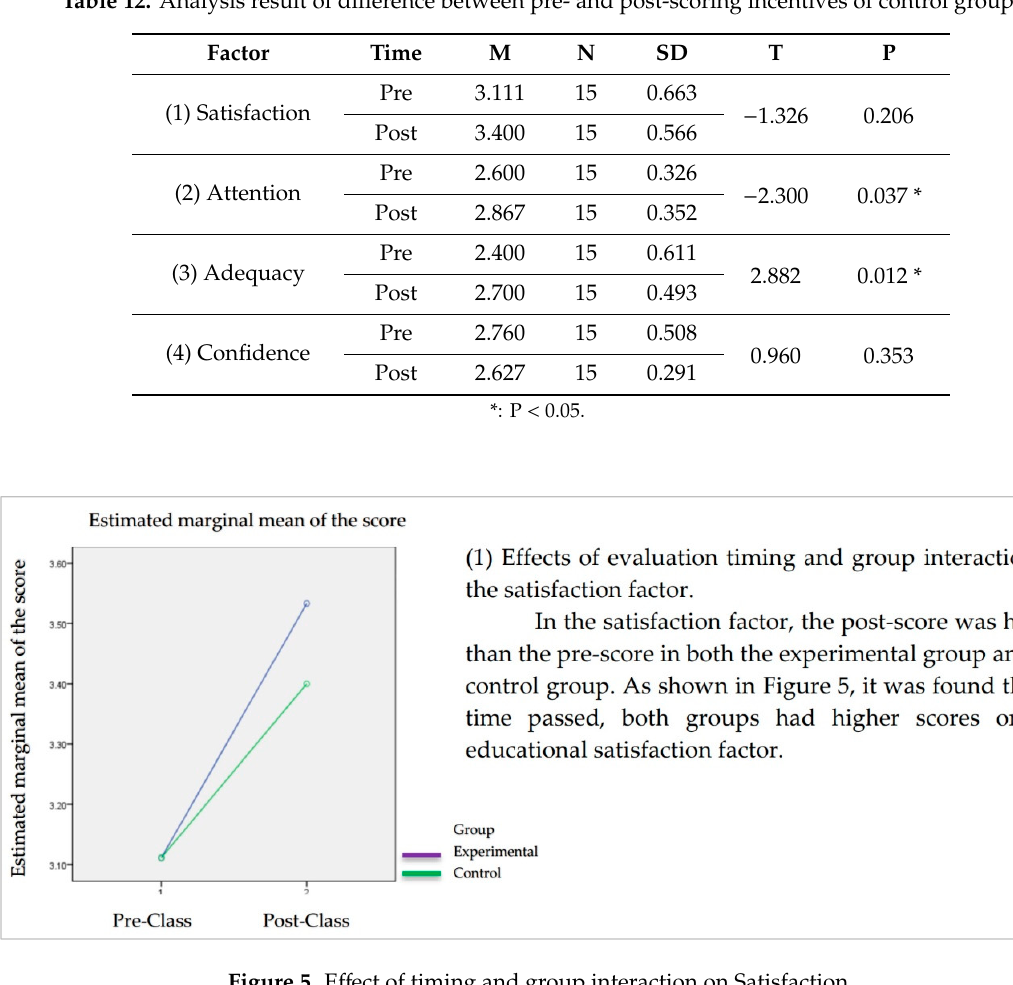
Figure 5. Effect of timing and group interaction on Satisfaction. Figure 5. E ff ect of timing and group interaction on Satisfaction. Appl. Sci. 2020 , 10 , x FOR PEER REVIEW